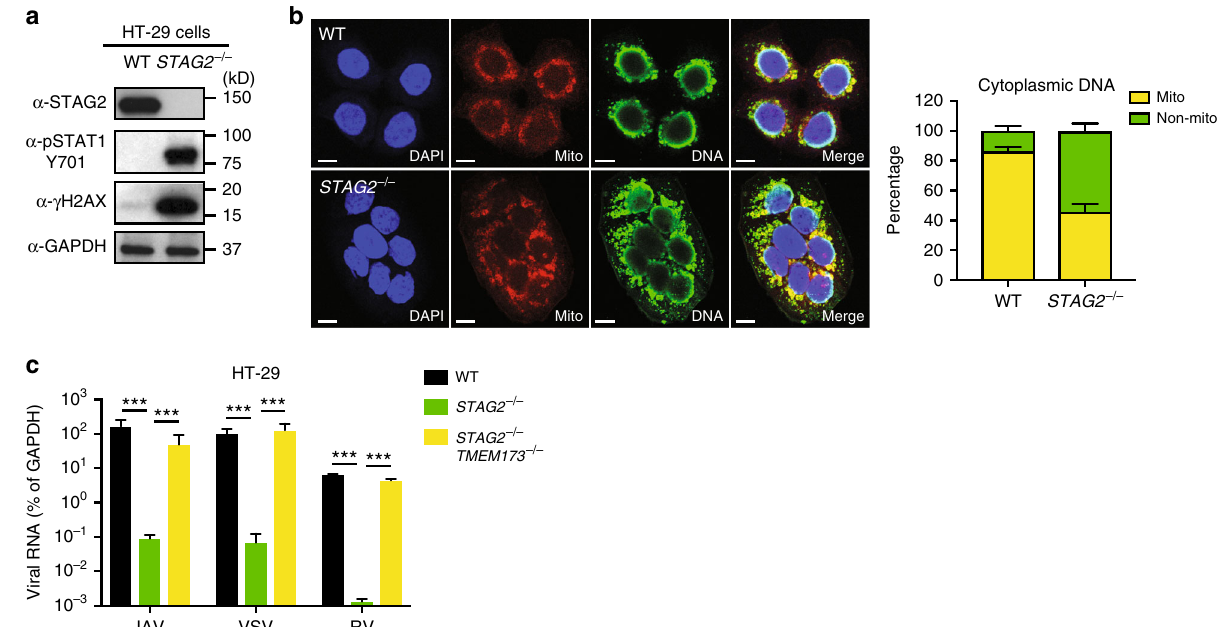
Fig. 3 STAG2 de fi ciency mediates DNA damage and activation of the cGAS-STING signaling. a WT and STAG2 − / − HT-29 cells were analyzed by western blot with the indicated antibodies. b Immuno fl uorescence analysis of WT and STAG2 − / − HT-29 cells: nucleus (DAPI, blue), mitochondria (MitoTracker, red), and cytoplasmic DNA (green). In merged panels, mitochondrial DNA is shown in yellow and non-mitochondrial cytoplasmic DNA is shown in green. Scale bar: 8 μ m. c WT, STAG2 − / − , and STAG2 − / − STING − / − HT-29 cells were infected with IAV, VSV, and RV (MOI = 1) and viral mRNA level was measured at 24 h.p.i. by RT-qPCR. IAV in fl uenza A virus, VSV vesicular stomatitis virus. For all fi gures, experiments were repeated at least three times in triplicates. Data are represented as mean ± SEM (***p ≤